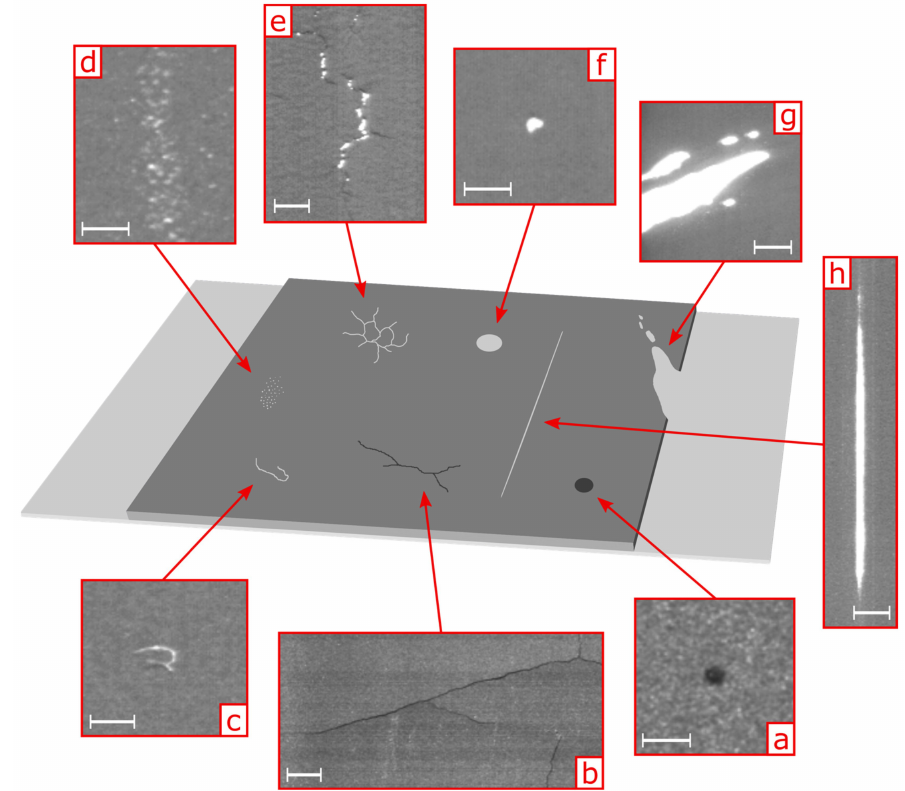
Figure 3. Set defect types for the electrode production on a continuous pilot scale coater: ( a ) Ag- glomerate, ( b ) Coating Crack, ( c ) Contamination, ( d ) Micro-compression, ( e ) Mud Crack, ( f ) Pinhole, ( g ) Slip, and ( h ) Stripe. The scale shown represents 1 mm. More defect pictures are shown in the Supplementary